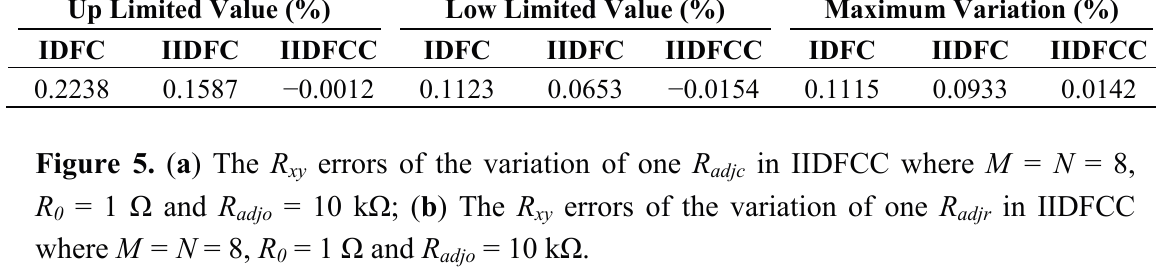
Table 2. R Error with one adjacent row element varied in 3–20 k Ω . xy